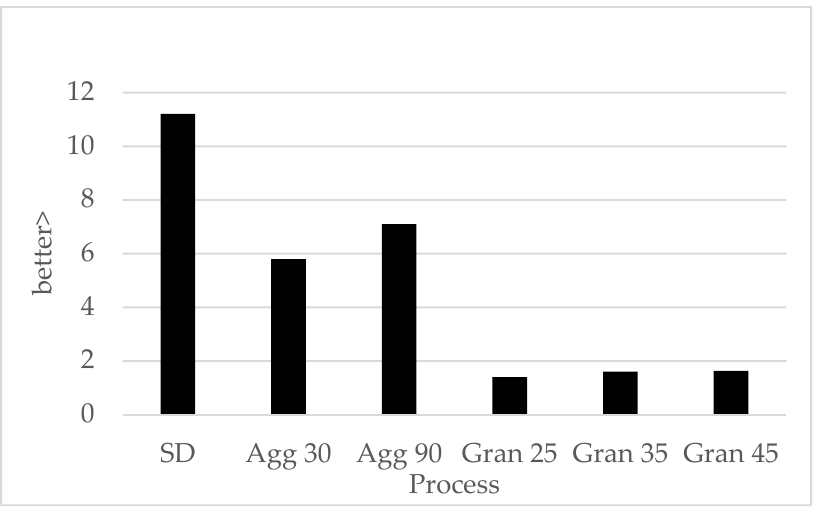
Figure 6. Extent of oxidation after 4 weeks storage at 45C. Oxidation is expressed as mg limonene oxide/g limonene (mgLO)/g limonene (L) .